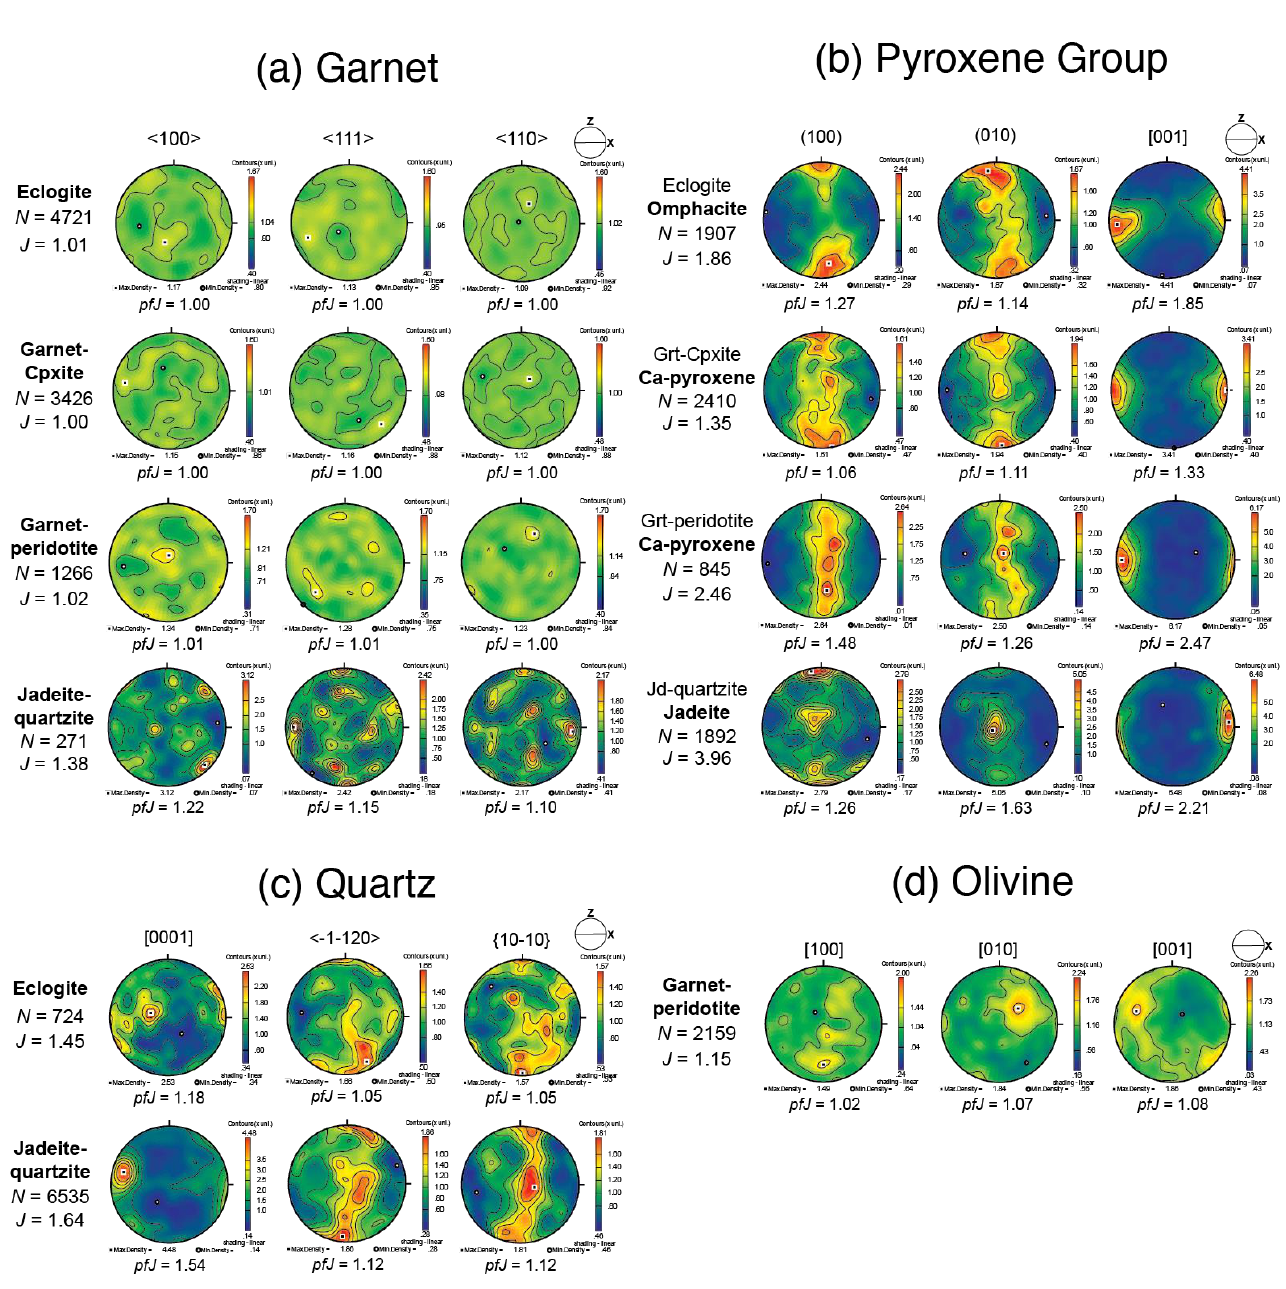
Figure 7. ( a ) Crystal-preferred orientation of garnet in each sample based on one point per grain and presented on equal-area, lower-hemisphere projections. The foliation is on the XY plane, and the lineation is on the X-axis (E–W). N is the number of grains. J is the J -index calculated by a Mtex function: textureindex. ( b ) For pyroxene minerals. ( c ) Quartz in eclogite and jadeite quartzite. ( d ) Olivine in garnet peridotite.